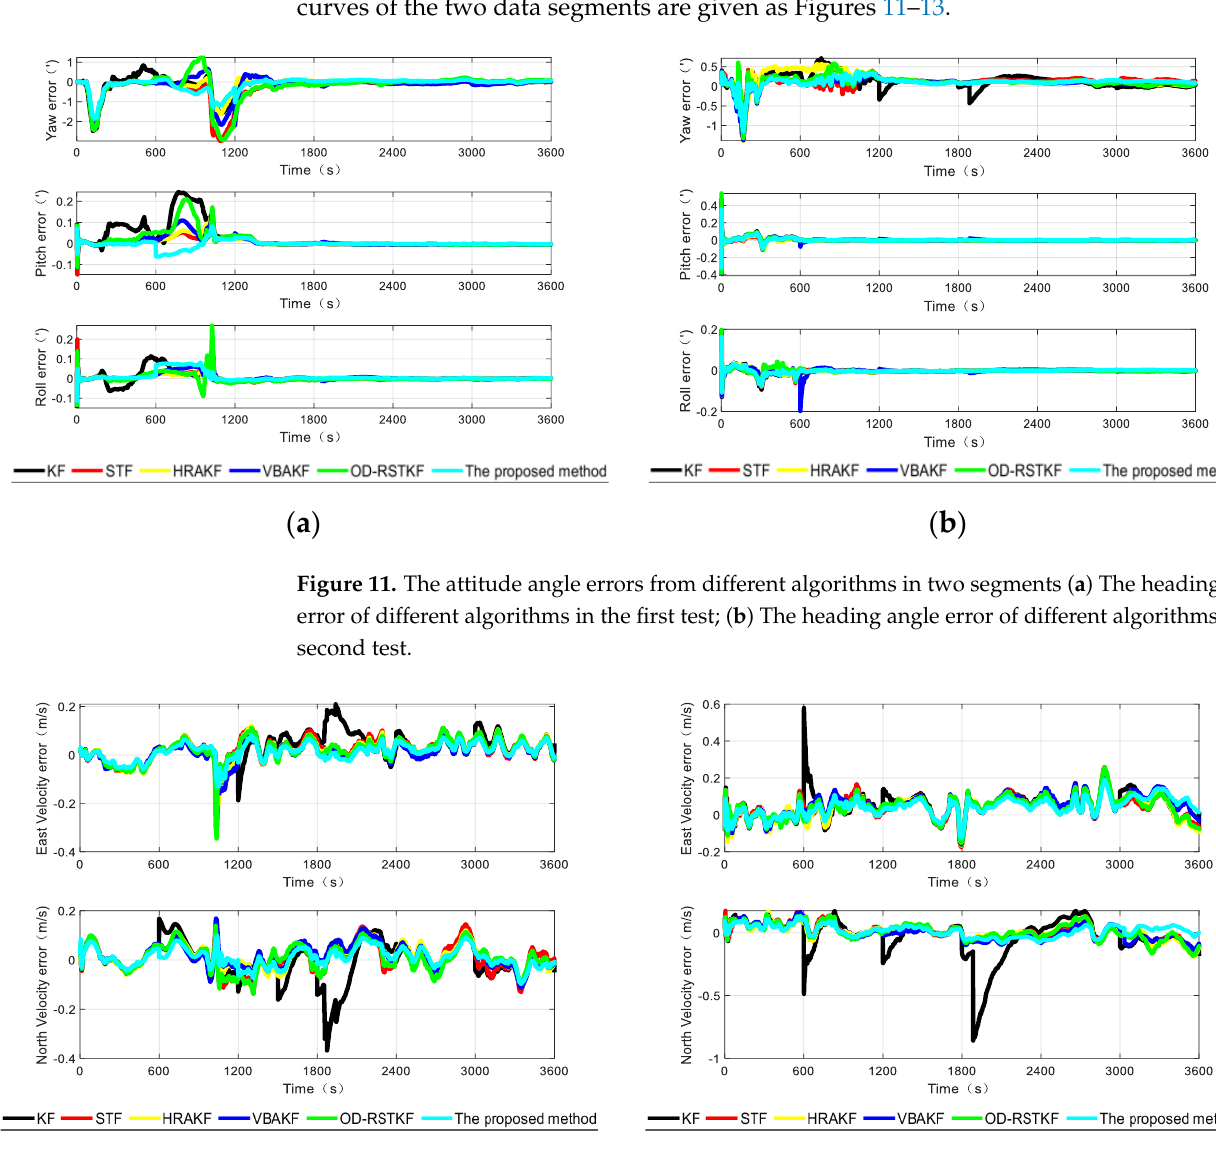
Figure 13. The position errors from different algorithms in two segments ( a ) The position error of different algorithms in the first test; ( b ) The position error of different algorithms in the second test.